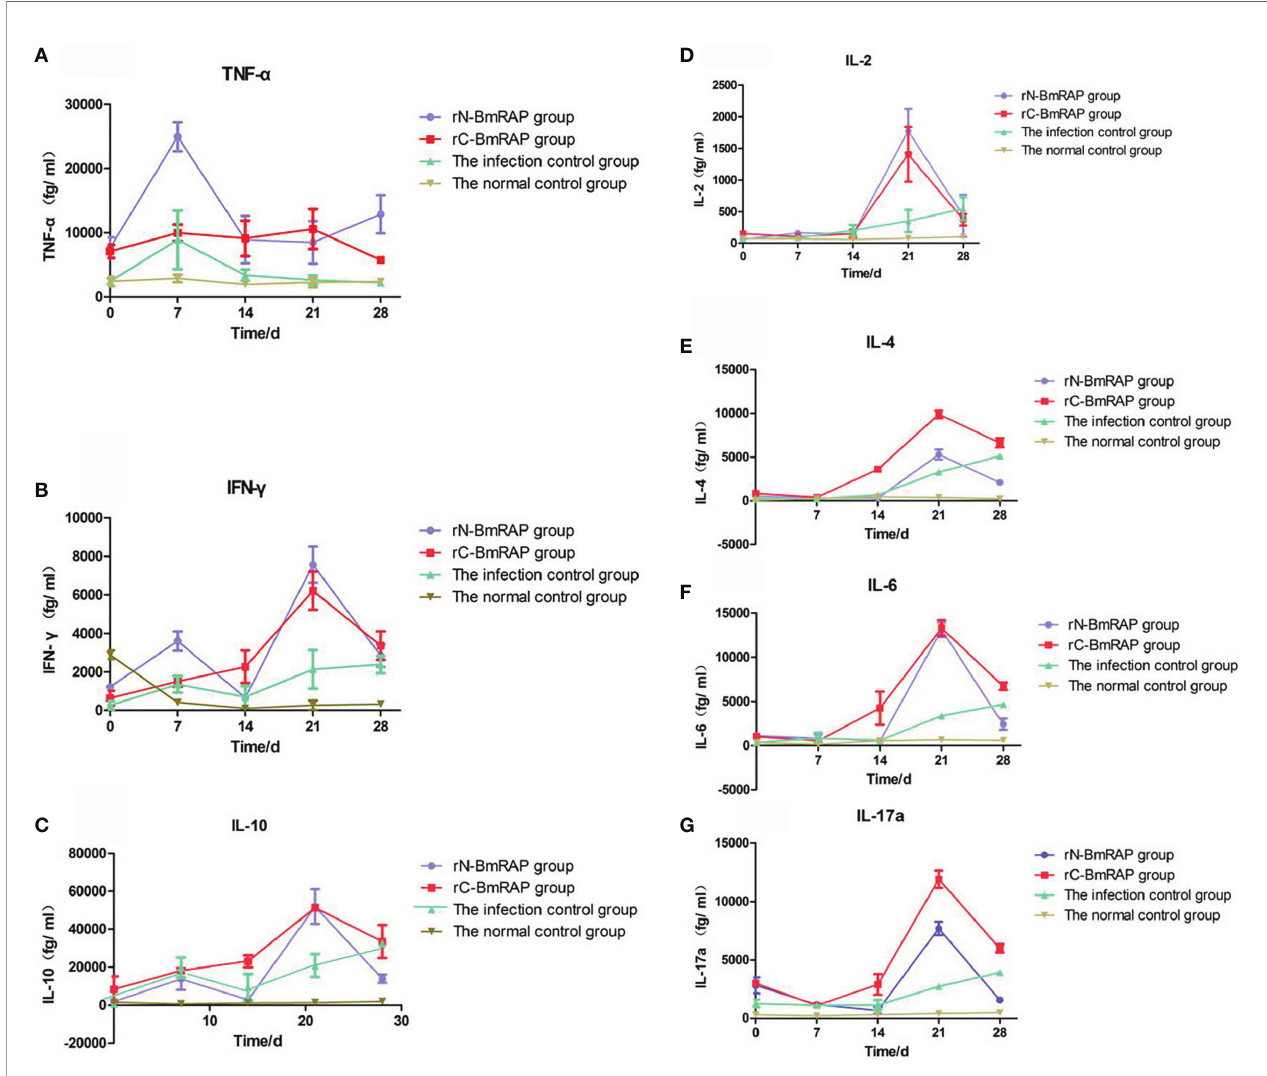
FIGURE 6 | Cytokine concentrations. (A) Tumor necrosis factor (TNF- a ); (B) Interferon-gamma (IFN- g ); (C) IL-10; (D) IL-2; (E) IL-4; (F) IL-6; (G) IL-17 a . Normal control group (brown line, inverted triangles); Infected control group (green line, triangles), rC-BmRON2 group (red line, squares), rN-BmRON2 group (purple line,